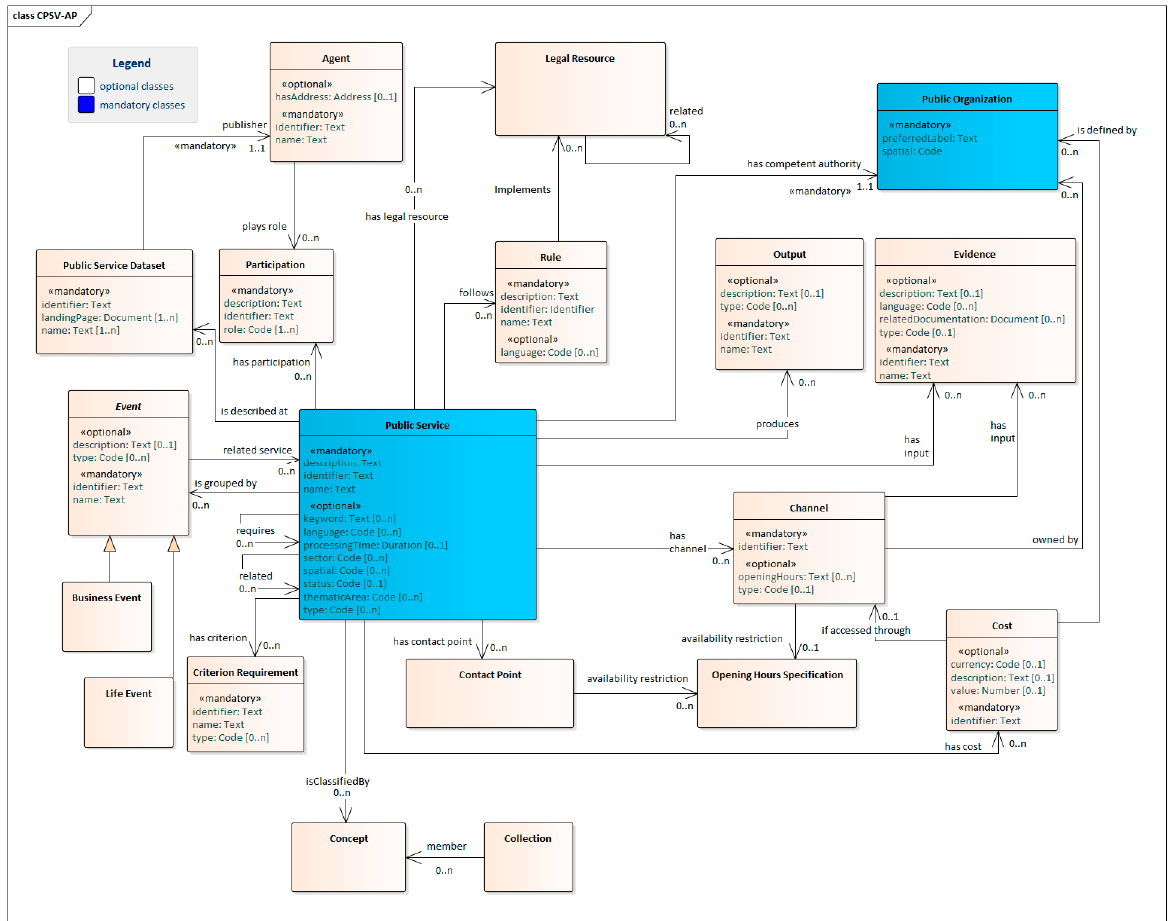
Figure 1. UML diagram of CPSV-AP 2.2.1 (adopted from [4]).